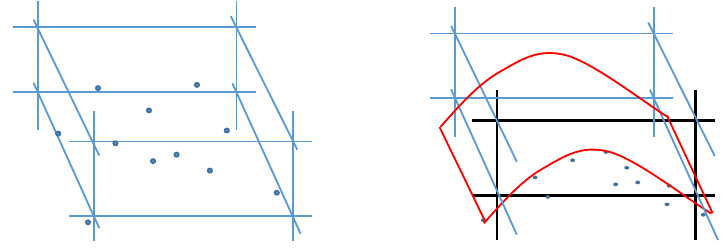
Figure 9. Approximation of the irregularly distributed surface roughness in a cell.